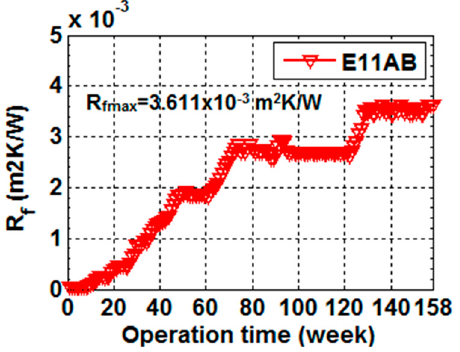
Figure 5. Fouling factor versus time during three years of operation of a selected HE.